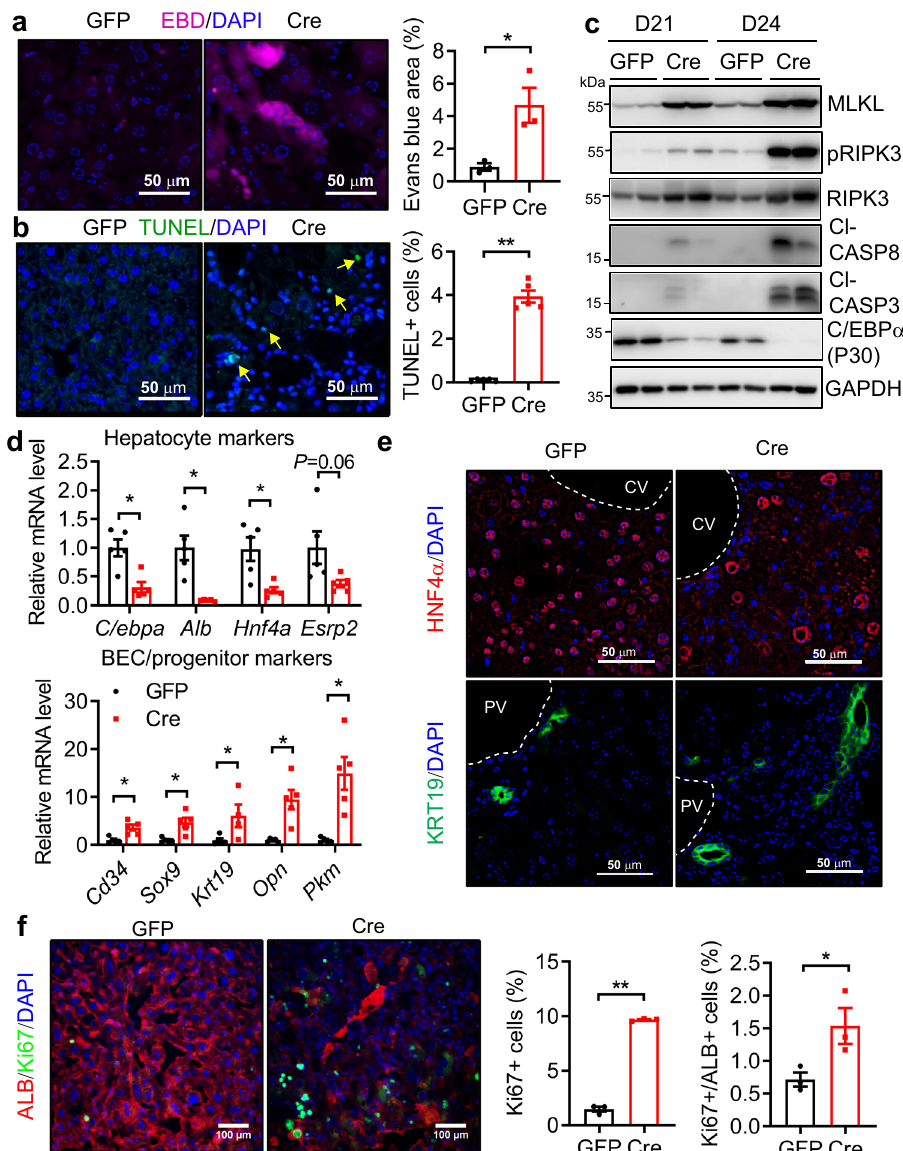
Fig. 3 | Hepatic neddylation de fi ciency promotes hepatocyte damage and excessive fetal liver reprogramming. a Representative EBD staining and quanti- fi cation of total EBD + areas ( n =3 per group, * P =0.0255); b representative TUNEL labeling and quanti fi cation of TUNEL + cells ( n =5 per group, ** P <0.0001) in livers of AAV-GFP ( GFP) and AAV-Cre (Cre) mice at D24 post virus injections. Scale bar: 50 µ m. Unpaired t -tests, two-tailed in ( a , b ). c Representative Western blot in liver extractsofGFPandCremiceatD21andD24post-virusinjections( n =4pergroup). d RelativemRNAlevelsofmaturehepatocytemarkersandBEC/progenitor-speci fi c markers in livers as determined by qRT-PCR ( n =5). Multiple unpaired t -tests with